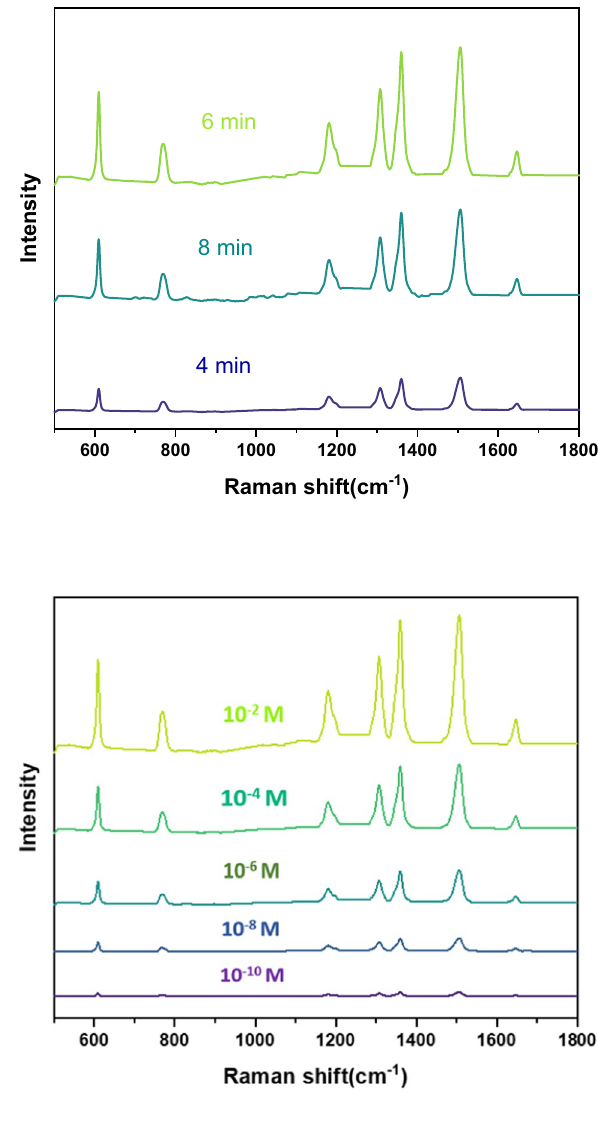
Fig. 3 Rhodamine spectrum of SERS substrate with various reaction time